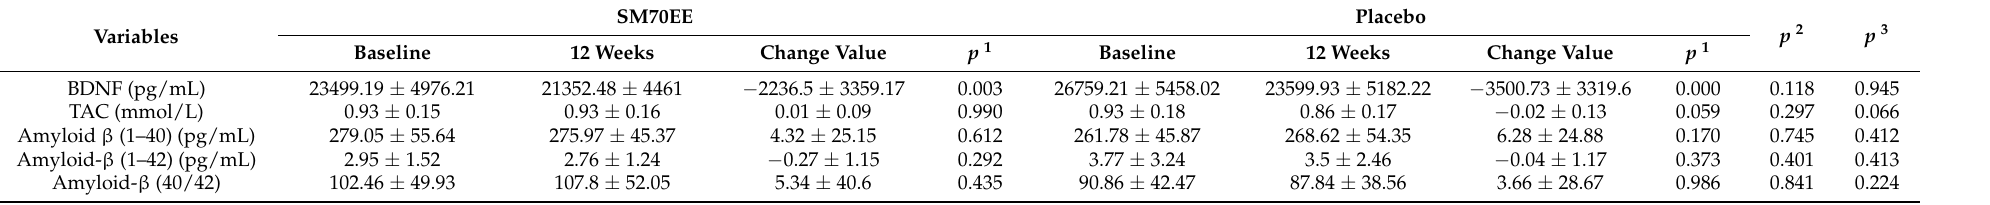
Table 5. Changes in biomarkers before and after 12 weeks of SM70EE product